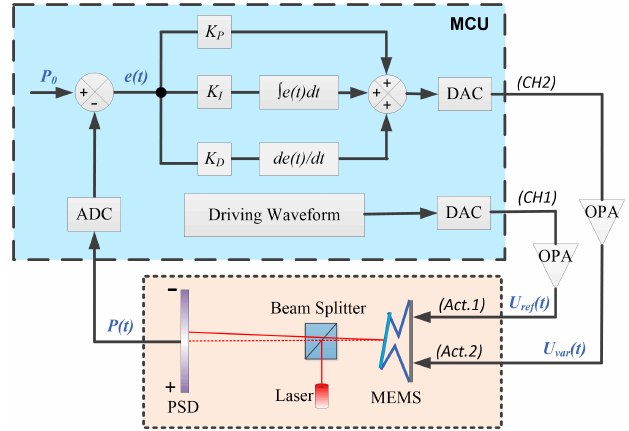
Figure 6. The block diagram of the closed-loop control. Note: MCU is micro control unit, ADC is analog to digital converter, DAC is digital to analog converter, OPA is operational amplifier, and PSD is position-sensitive device.